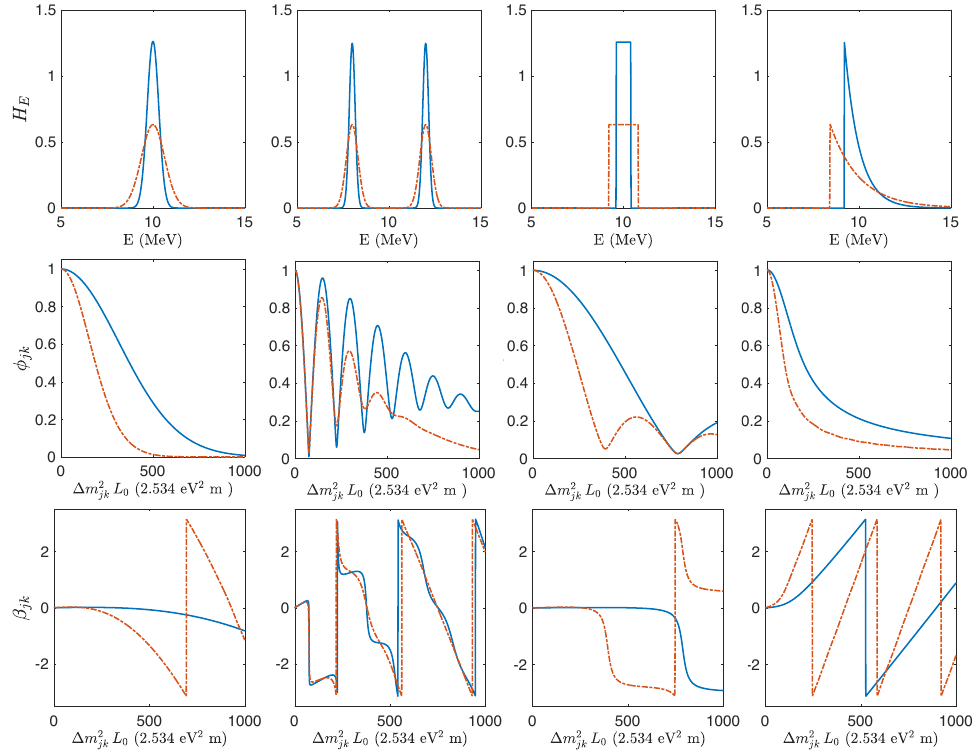
Figure 11 . Phase decoherence by the macroscopic energy uncertainty σ E on the physical layer as a phase wash-out effect. Including a damping term and a phase shift term in eq. (3.1) for different √ √ shapes of H with the same widths ( σ MeV for the blue line, σ E 0 = 0 . 1 E E / for the red line), at energy E = 10 0